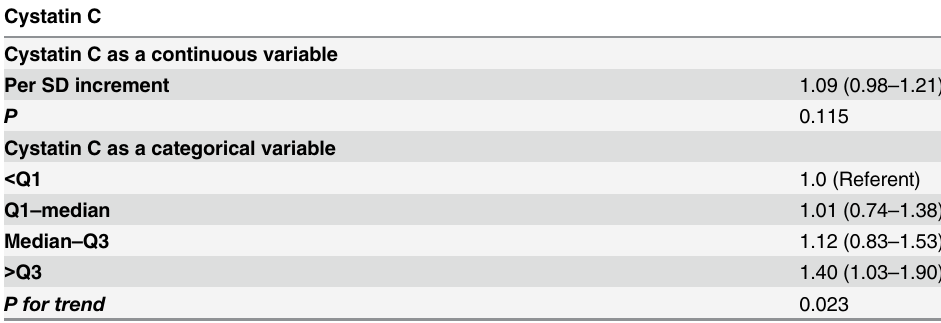
Values are odds ratios (95% con fi dence intervals) for incident MetS from logistic regression analyses. adjusted for age, sex, systolic blood pressure, antihypertensive treatment, waist circumference, plasma levels of triglycerides, fasting whole-blood glucose and HDL at baseline. n = 2709 with 562 MetS